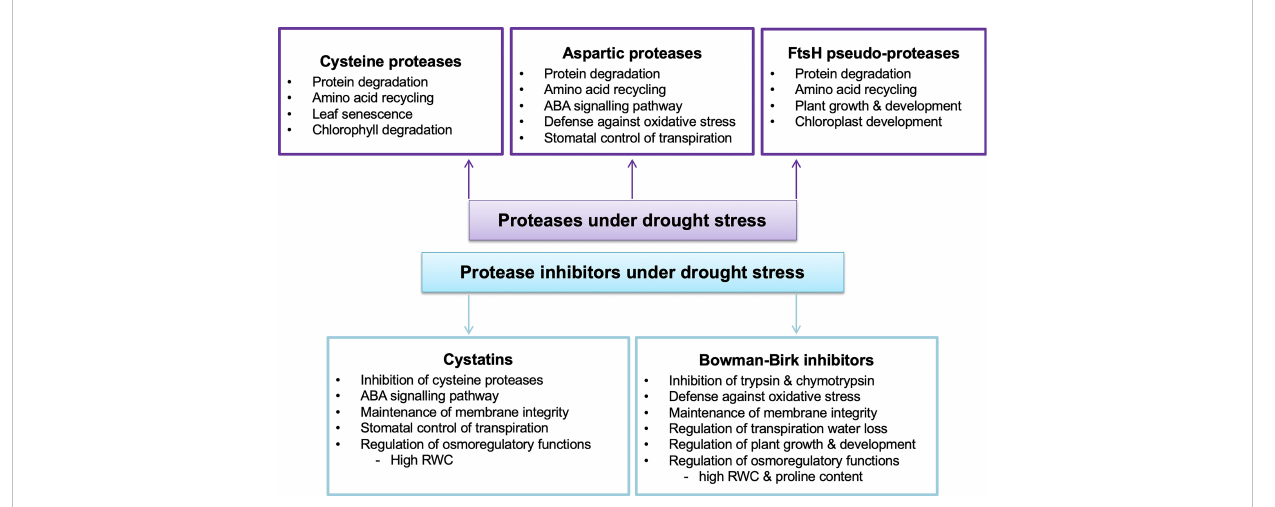
FIGURE 3 Physiological functions of selected proteases and protease inhibitors in drought-stressed plants inferred from transgenic studies. ABA, Abscisic acid; RWC, relative water content. (Chen et al., 2010; Yao et al., 2012; Tan et al., 2017; Malefo et al., 2020; Sebastia ́ n et al., 2020; Mishra et al.,